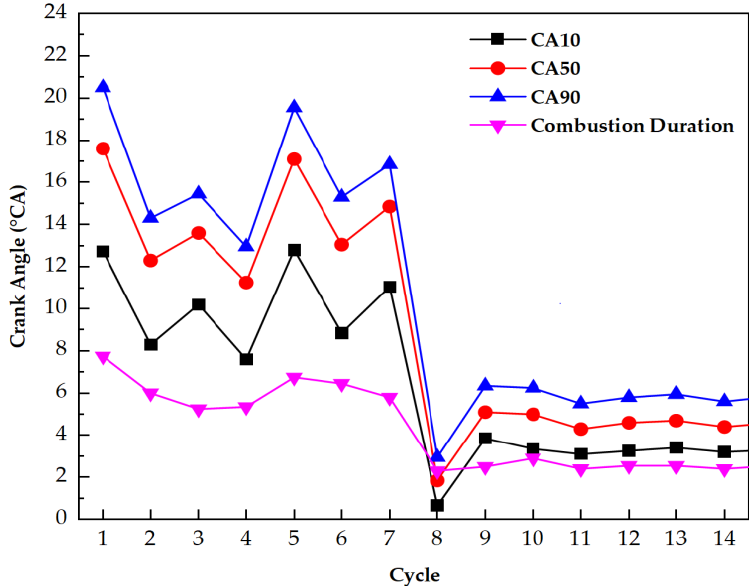
Figure 13. CA10, CA50, CA90 and Combustion Duration changes during switching.